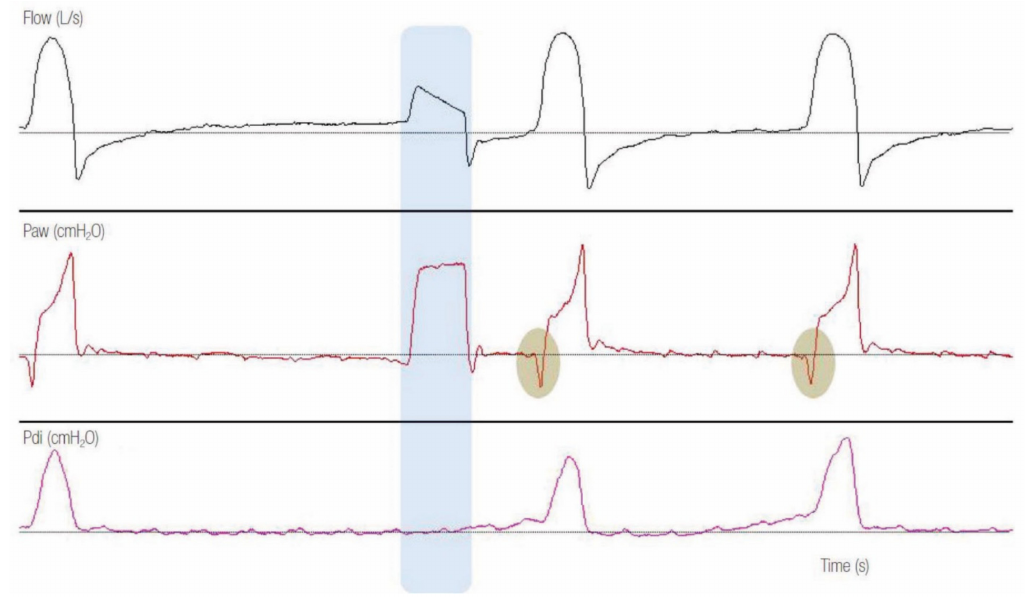
Figure 2. Example of a tracing with autotriggering in pressure support ventilation mode. Note the absence of transdiaphrag- matic pressure (Pdi) increase, indicating no inspiratory effort, before the second ventilator breath (blue shaded area). Observe that, in comparison to patient-triggered breaths, where a decrease in airway pressure (Paw) is noticed before the start of ventilator inflation (grey shaded areas), there is no twisting in the Paw (no decrease in Paw) in the autotriggered breath [18].